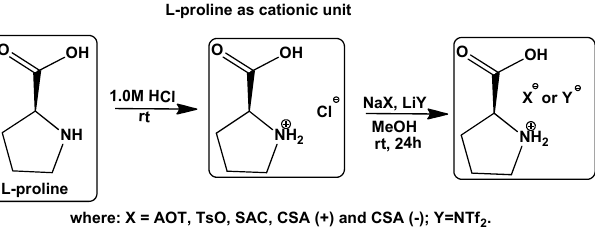
Figure 2. General strategy for the synthesis of CILs based on L-proline as cationic unit .